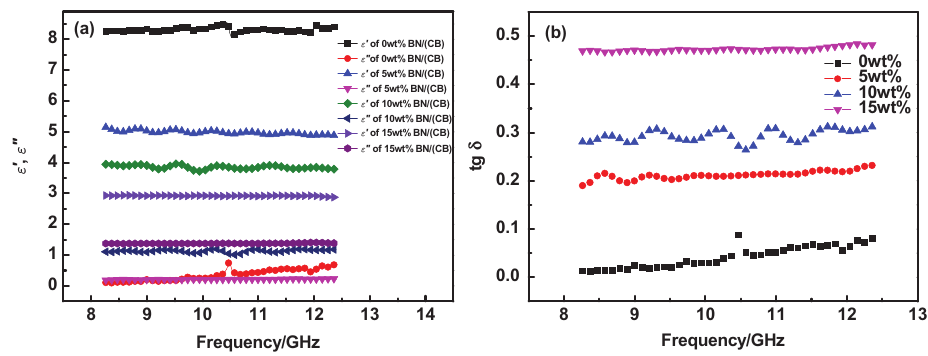
Figure 9: Dielectric properties of Si 3 N 4 /BN(CB) composite ceramics: (a) ε ′ , ε ″ and (b) tg δ .